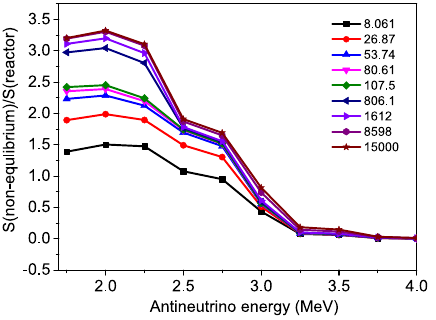
Figure 6. nonequilibrium corrections based on E d and T 1 / 2 10 h ≥